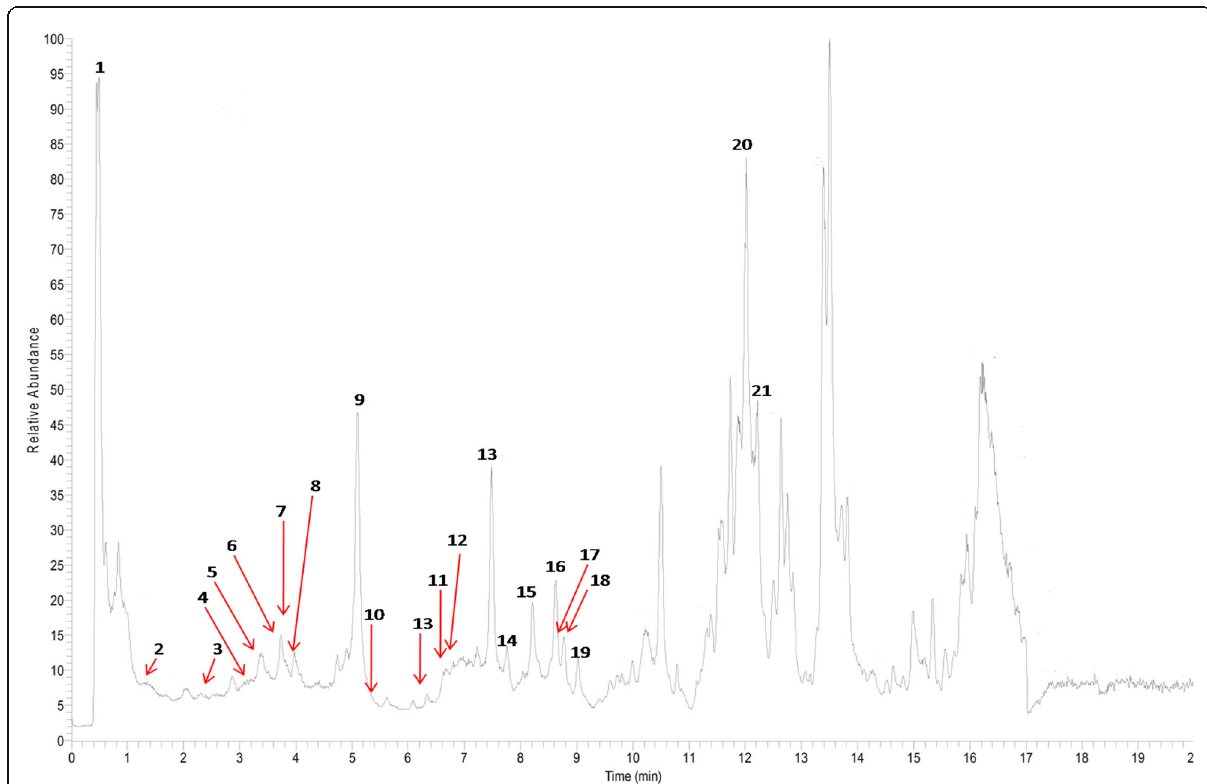
Fig. 6 UHPLC analysis of MMMC in negative ion mode. Total ion chromatography (TIC) profile of the 1:1 (v/v)